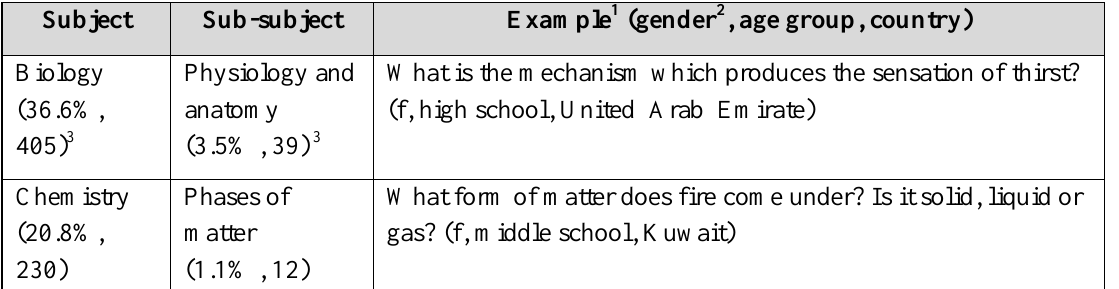
Examples of the Questions Analyzed According to their Topic and their Frequency within Various